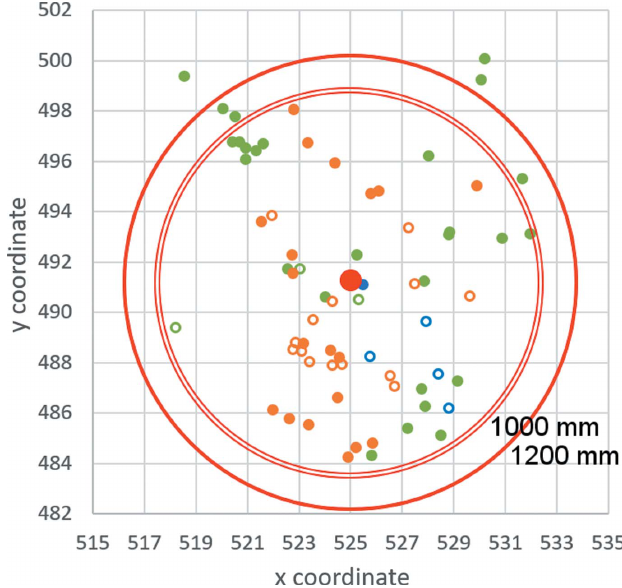
Figure 3 The centres of distortions refined against tens of 3D ED datasets for diffraction lens excitations equal to eucentric focus (green), 102.8% of the eucentric focus (orange) and 105.6% of the eucentric focus (blue) for camera lengths of 1000 mm (empty circles) and 1200 mm (full circles). The average position is marked by a red dot. The physical pixel size is 7.4 (cid:3) 7.4 mm and the number of pixels is 1024 (cid:3) 1024. The outer red rings mark distances of 0.03 A˚ (cid:5) 1 from the average position of the distortion centre for the two camera